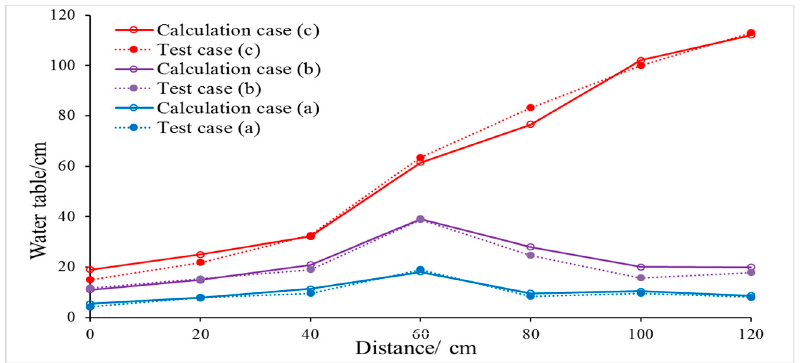
Figure 4. Comparison of flow profile.